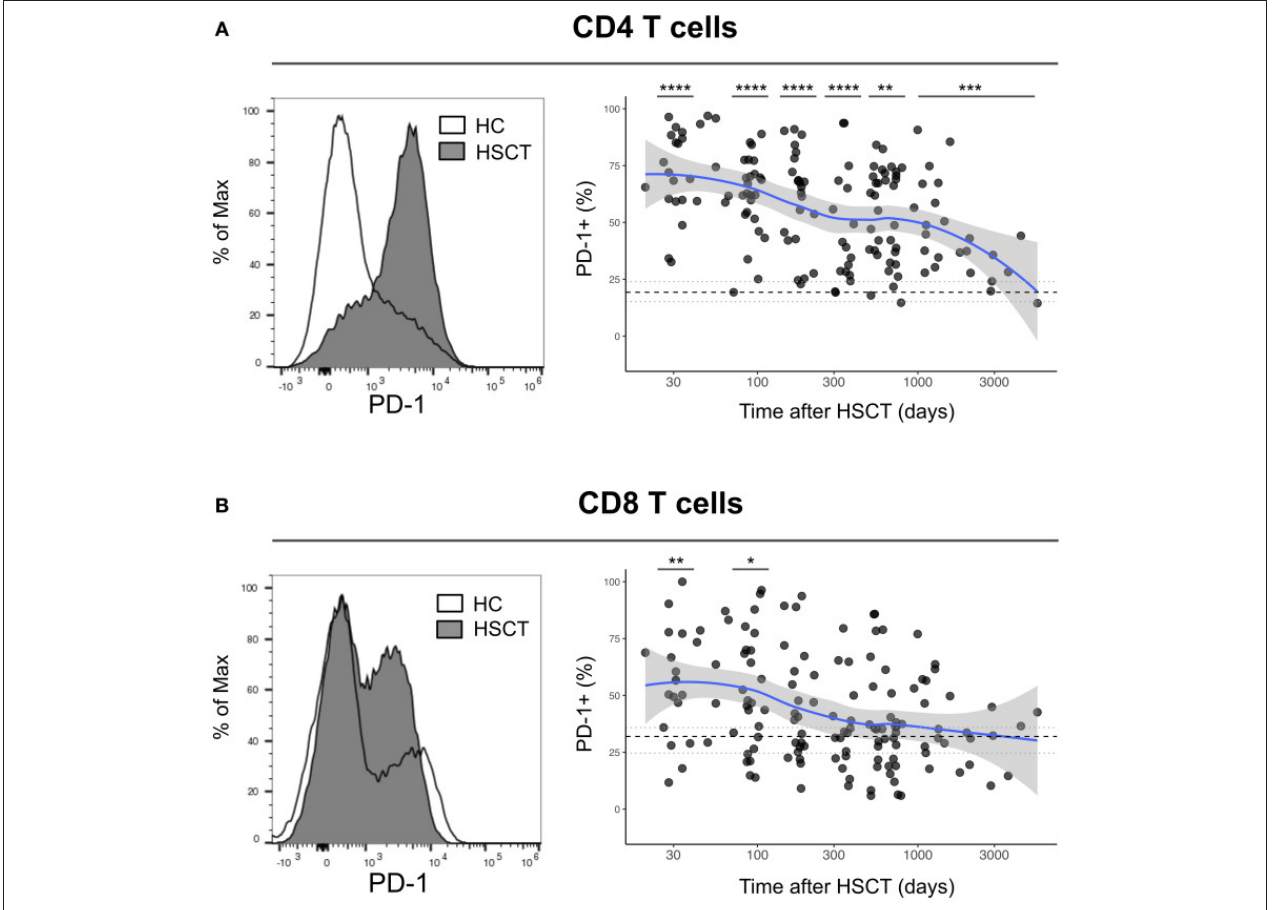
FIGURE 1 | Dynamics of PD-1 expression on CD4 and CD8T cells after allogeneic HSCT. (A,B) Histograms representing PD-1 expression on CD4 (A) or CD8 (B) T cells from HC (open line) or a HSCT recipient at day 30 post-HSCT (gray filled histogram). Graphs represent proportions of PD-1 expressing CD4 (A) or CD8 (B) T cells from HSCT recipients and their relationship with time since HSCT. Dark gray dots represent each sample, blue lines represent medians and the gray area represents the confidence interval. Median (black dashed line), 25th and 75th percentiles (gray dotted lines) of PD-1 expressing T cells from HC are represented. The p- values of expression in HSCT recipient groups at 1, 3, 6, 12, and > 24 months compared with HC are indicated (Mann-Whitney U -test; * p < 0.05, ** p < 0.01, *** p < 0.001, **** p <